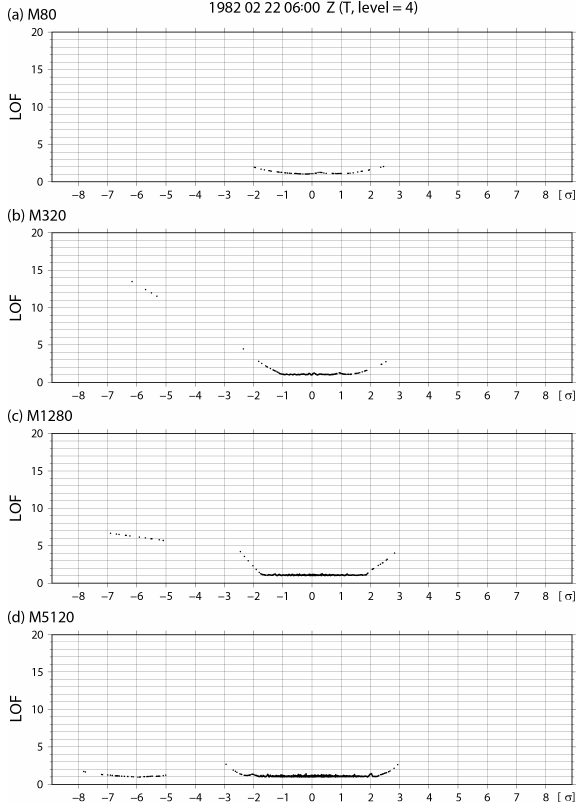
Figure 18. Similar to Fig. 5b, but for the ensemble sizes (a) 80, (b) 320, (c) 1280, and (d) 5120.